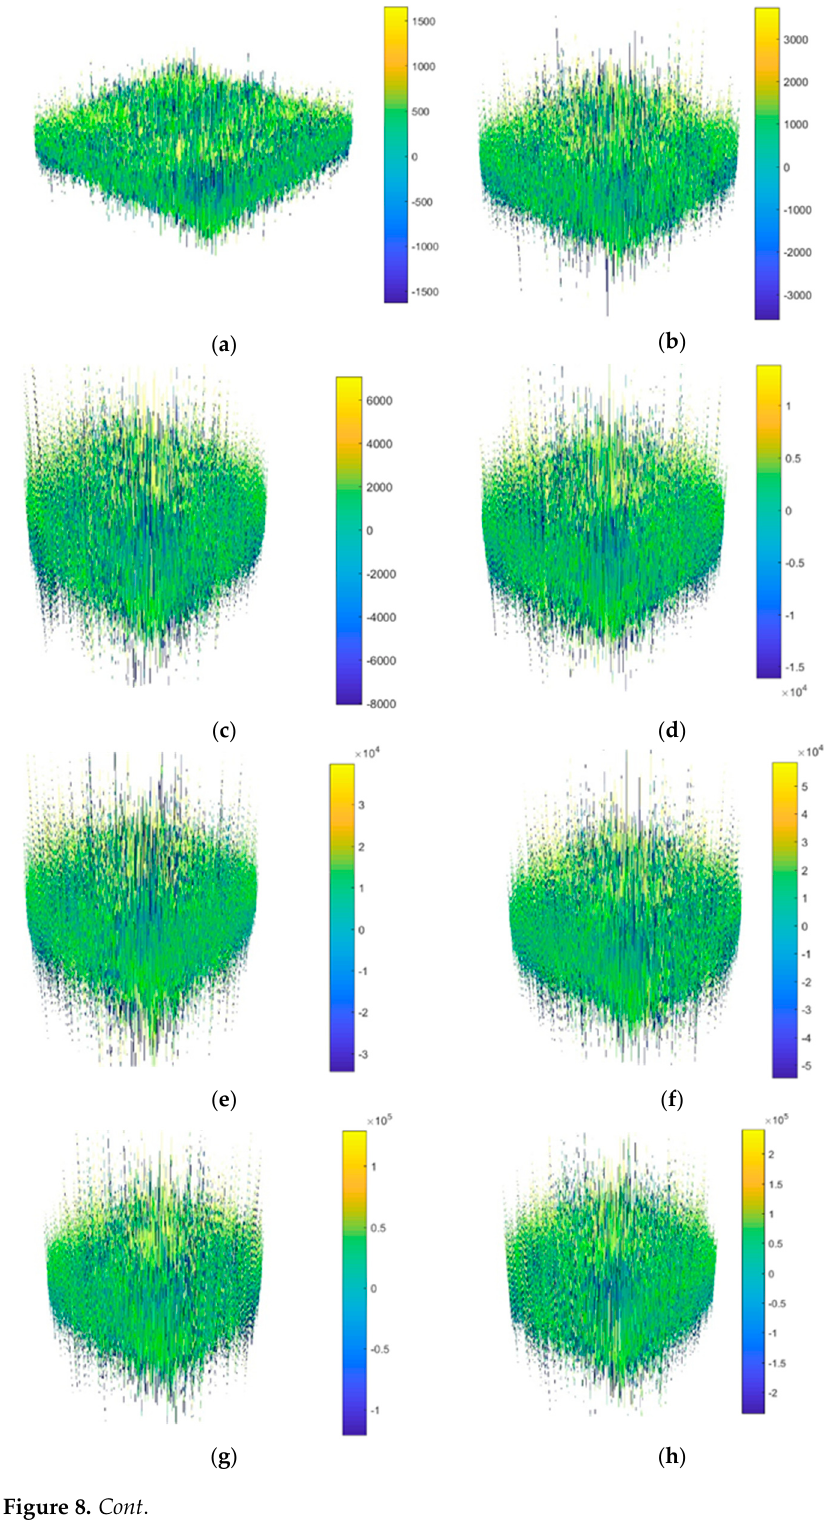
Figure 7. Ten confused DEM A.